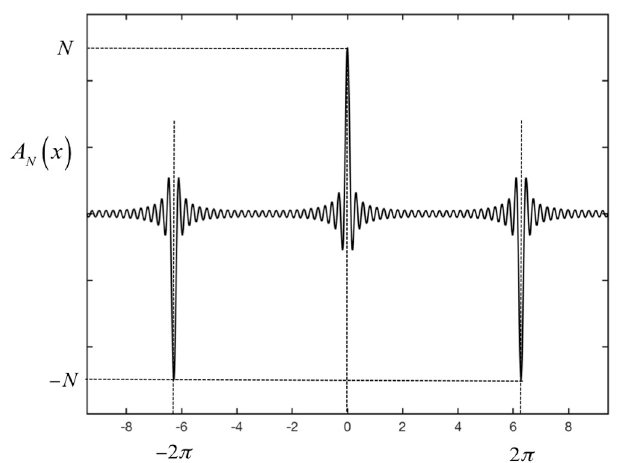
Figure 4. Plot of the mathematical function A N ( x ).